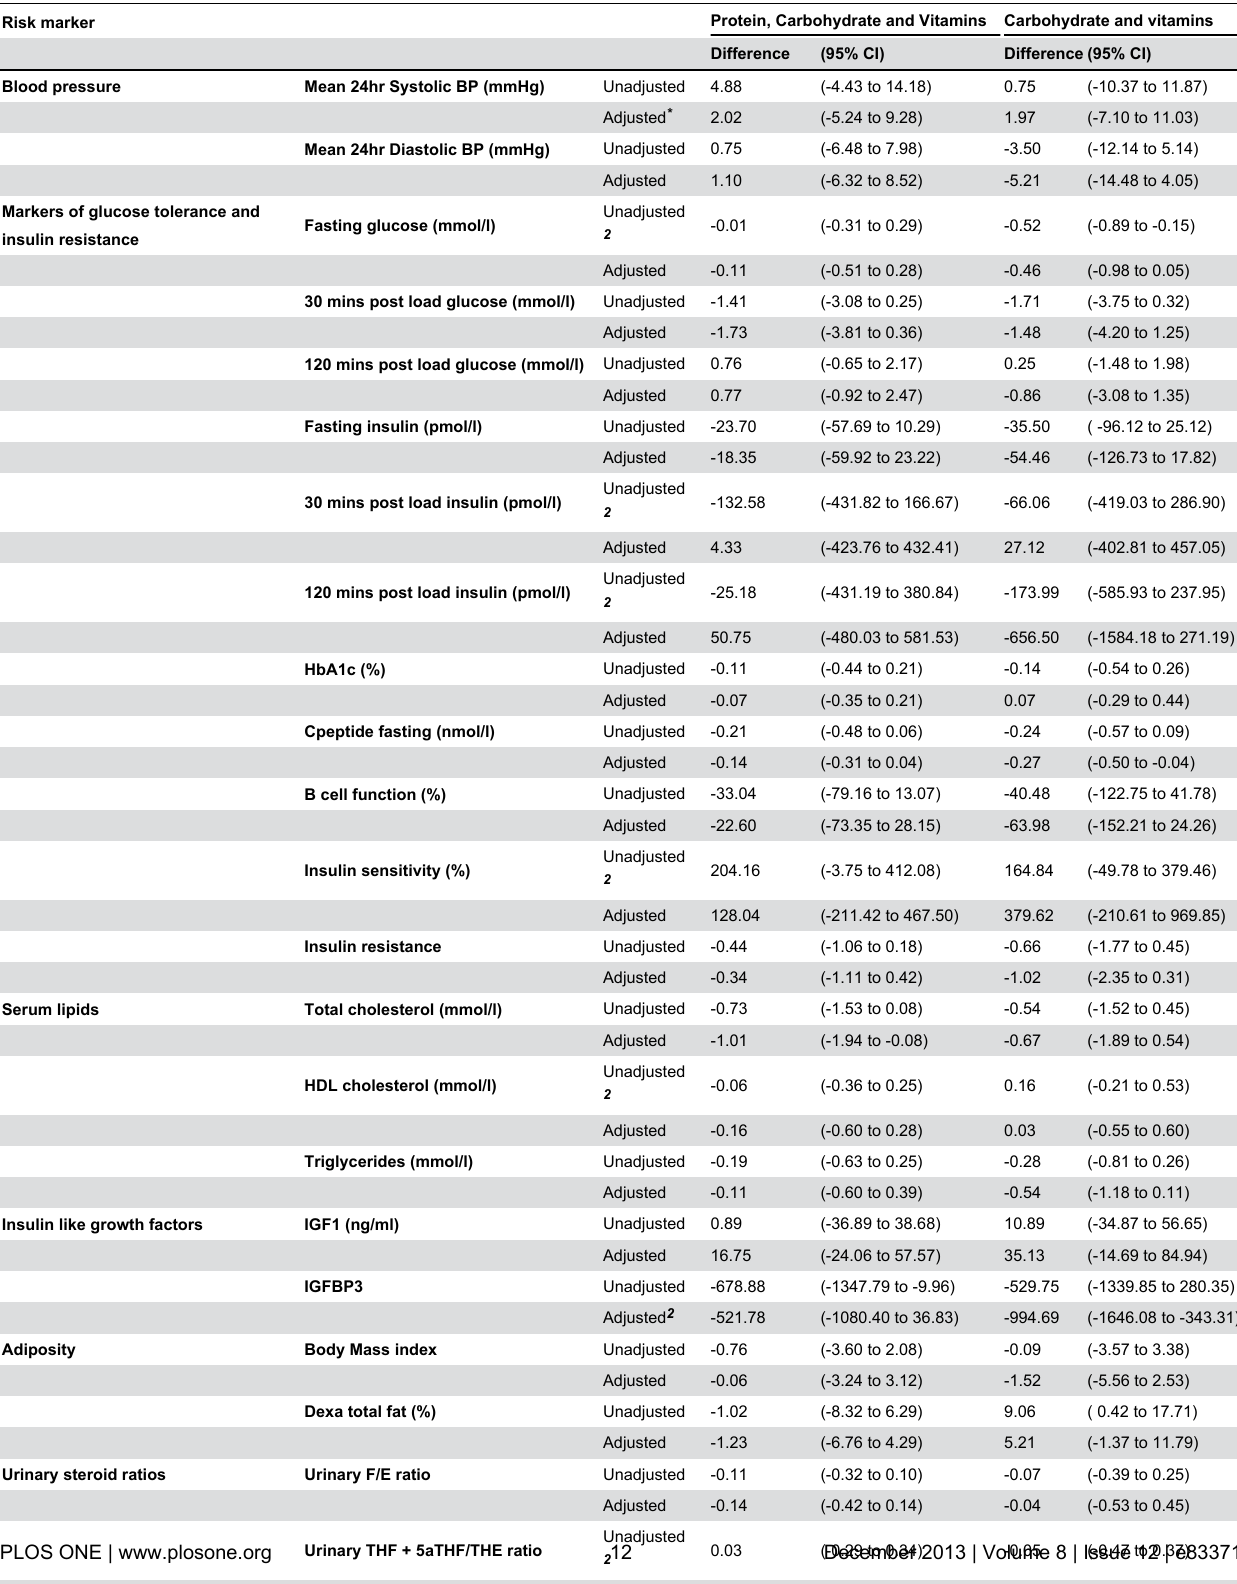
Table 6. Adult disease risk markers amongst offspring of mothers participating in the Sorrento studies of maternal nutritional supplementation who were assessed as adults: between group differences 1 - Trial II (supplementation in nutritionally at risk mothers after 28